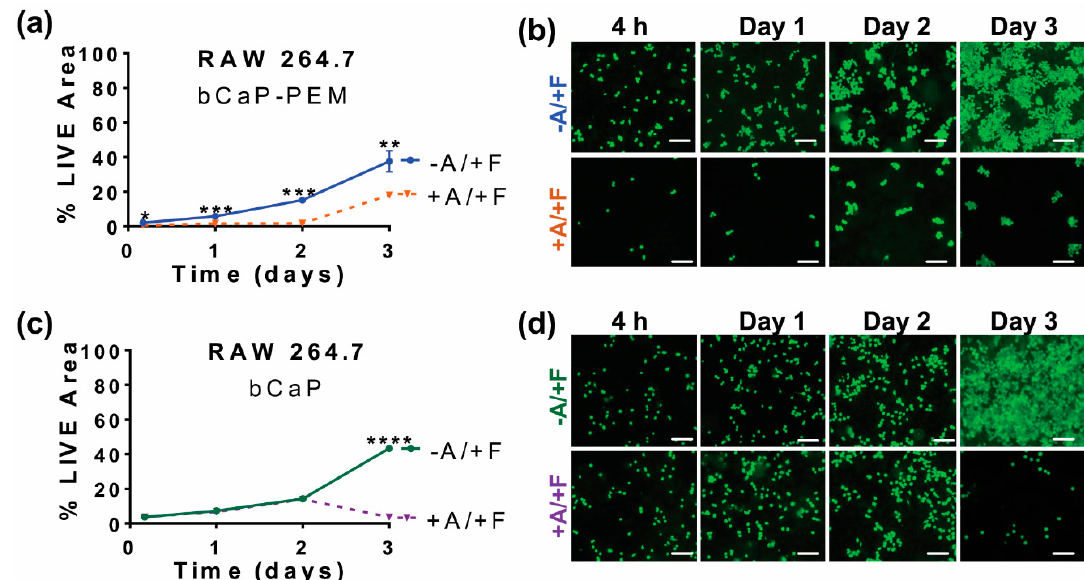
Figure 7. RAW 264.7 macrophages cultured on bCaP or bCaP-PEM: ( a ) percent LIVE ® stained area of RAW 264.7 cells cultured on bCaP-PEM30-FGF2 ( − A/+F) as compared to cells cultured on AntiA-bCaP-PEM30-FGF2 (+A/+F) ( * p ≤ 0.05, ** p ≤ 0.01, *** p ≤ 0.001); ( b ) fluorescent LIVE ® stained images of RAW 264.6 cells cultured on bCaP-PEM30-FGF2 ( − A/+F) as compared to cells cultured on AntiA-bCaP-PEM30-FGF2 (+A/+F) at 4 h, 1, 2, and 3 days of culture; ( c ) percent LIVE ® stained area of RAW cells on bCaP coating (**** p < 0.001); and ( d ) fluorescent LIVE ® stained images of cells cultured on bCaP-FGF2 ( − A/+F) as compared to cells cultured on AntiA-bCaP- FGF2 (+A/+F) at 4 h, and 1–3 days of culture. Scale bar = 100 μ m.